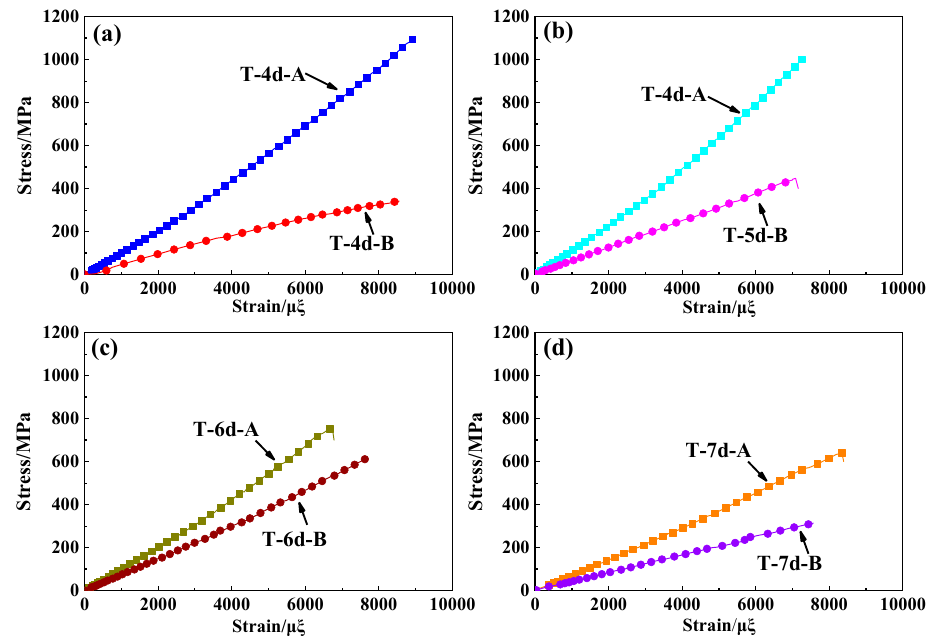
Figure 6. The tensile stress–strain curves of (a) 3D4dBC, (b) 3D5dBC, (c) 3D6dBC and (d) 3D7dBC.